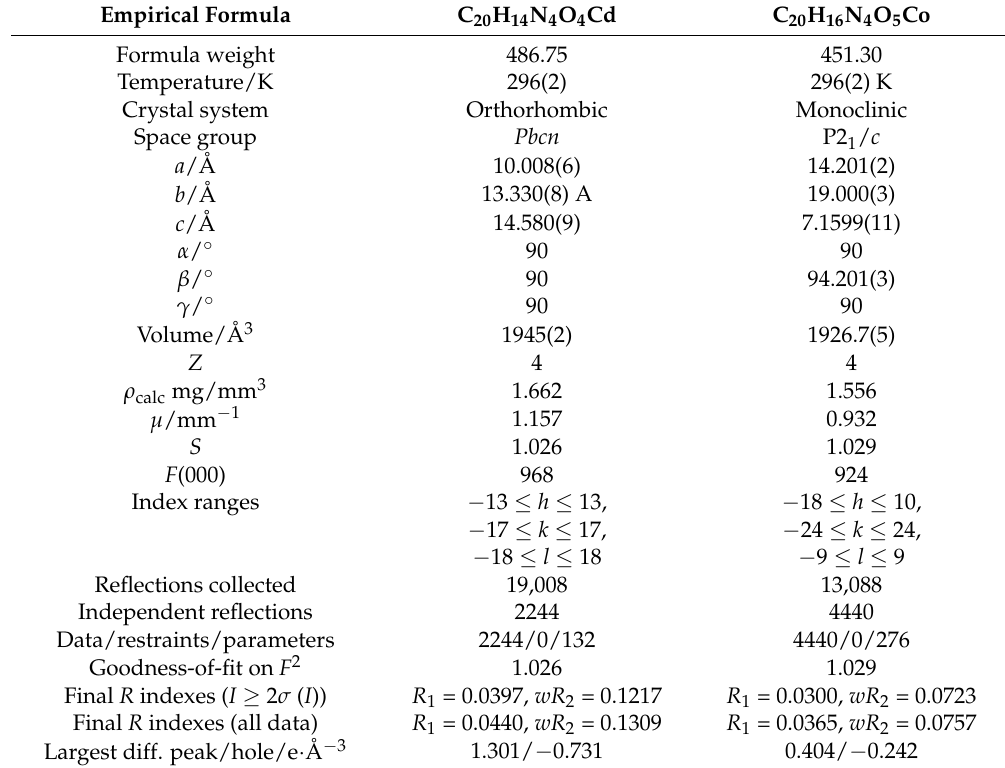
Table 2. Crystallographic data and structure refinement for 1 and 2